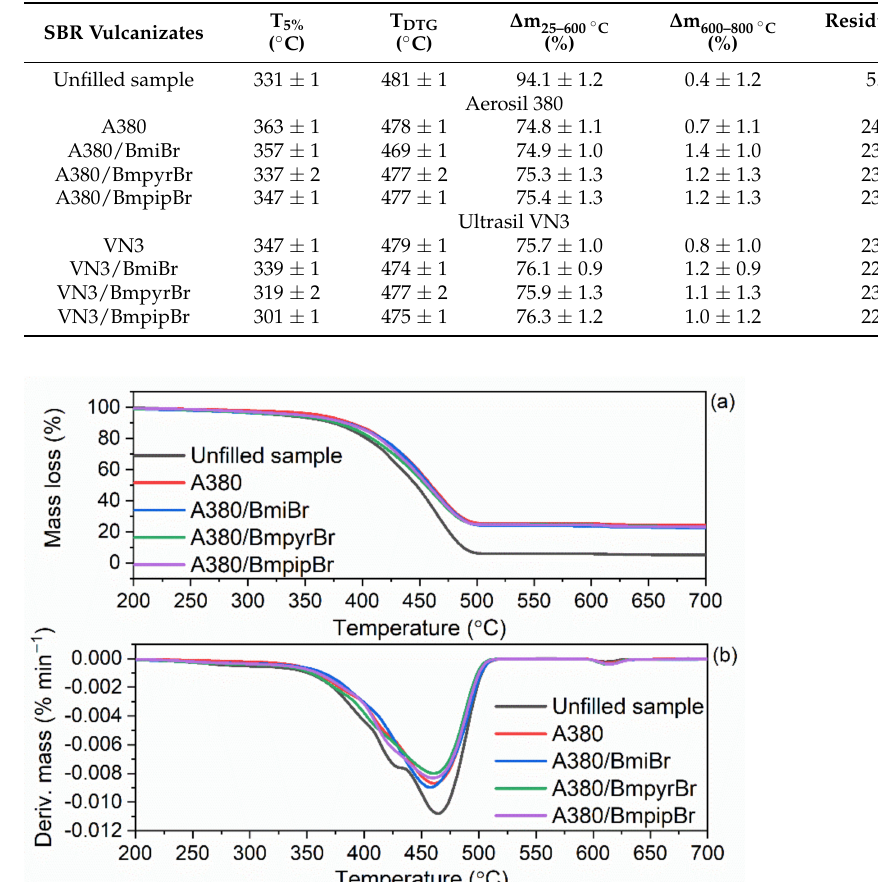
Table 8. Onset temperature of thermal decomposition (T 5% ), DTG peak temperature (T DTG ), and total mass loss ( ∆ m) during decomposition of SBR composites filled with silica A380 and VN3.